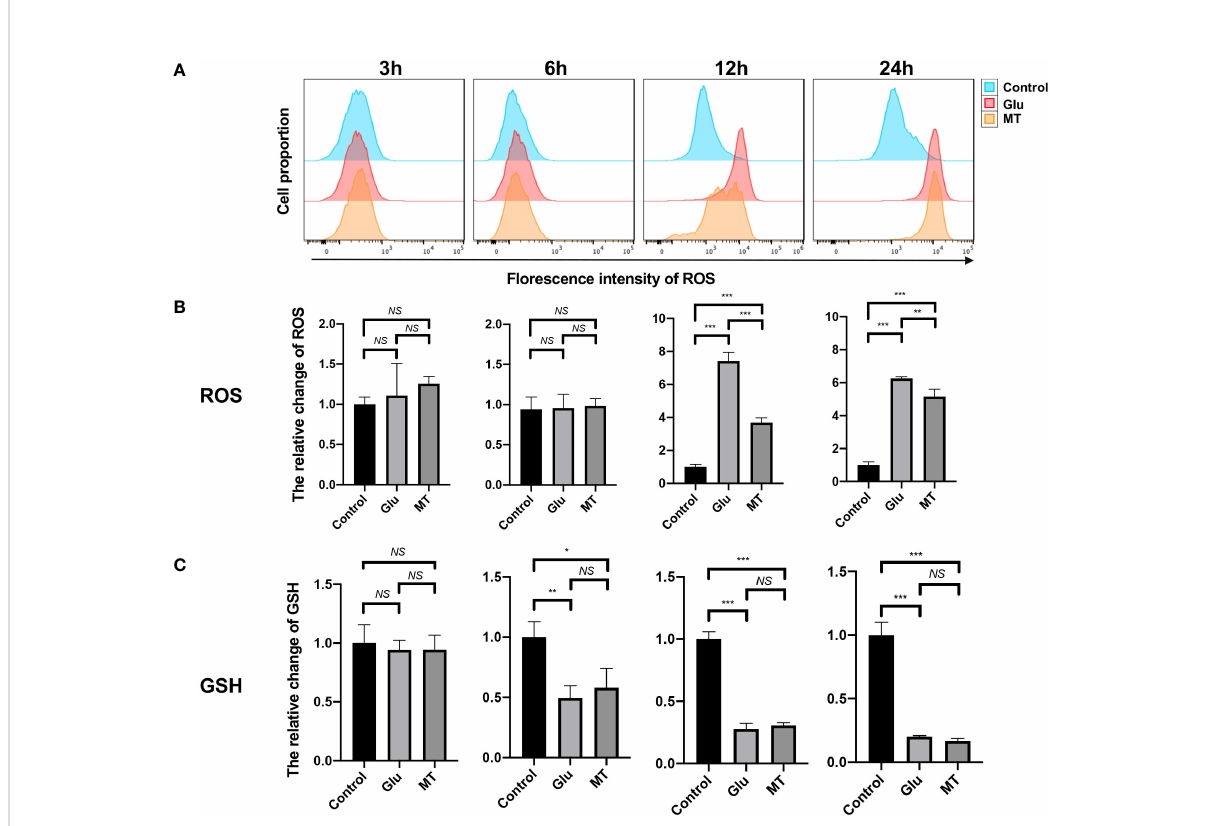
FIGURE 2 MT protects R28 cells from Glu-induced oxidative stress. (A, B) ROS levels increased gradually over time after glutamate treatment, and MT could ameliorate this change. (n = 3) (C) GSH levels decreased over time, but MT treatment could not rescue this change. (n = 3) Data are the mean ± SD; NS, No Signi fi cant, *p < 0.05, **p < 0.01, ***p <